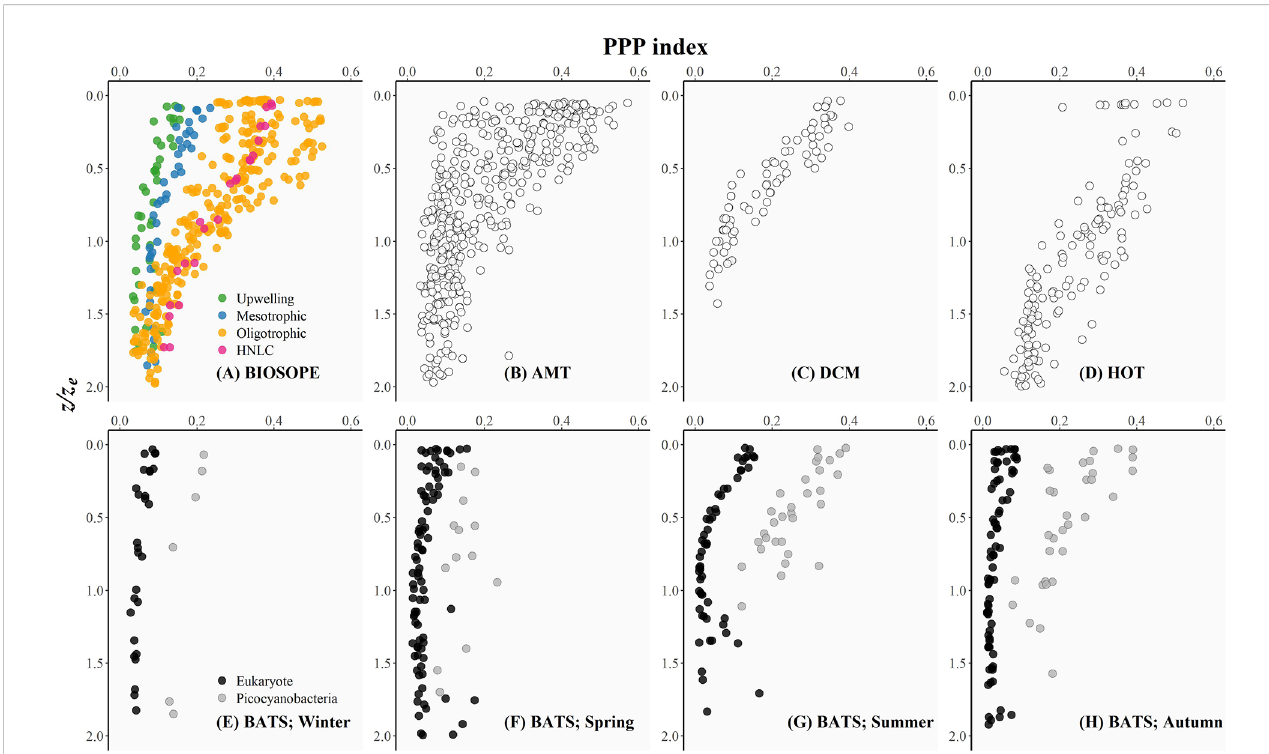
FIGURE 3 The photoprotective pigment index (PPP index: the ratio of PPPs to the sum of all pigments) plotted as a function of the depth of sampling divided by the depth of the euphotic zone ( z / z e ) as an index of the underwater light availability for each oceanographic dataset included in this study: (A) BIOSOPE, (B) AMT, (C) DCM, (D) HOT, and (E-H) BATS (see the Methods section for details of each cruise). The BIOSOPE dataset was partitioned into the coastal upwelling, mesotrophic, oligotrophic, and high-nutrient, low-chlorophyll (HNLC) regions as described in Grob et al. (2007a). The BATS time series was roughly divided into seasons: (E) winter (21 December – 20 March), (F) spring (21 March – 20 June), (G) summer (21 June – 20 September), and (H) autumn (21 September – 20 December). For each season, phytoplankton communities were classi fi ed into those dominated by eukaryotic taxa (no detectable zeaxanthin; black circles) and those dominated by picocyanobacteria (ratio of zeaxanthin to the sum of all PPPs ≥ 0.6; grey